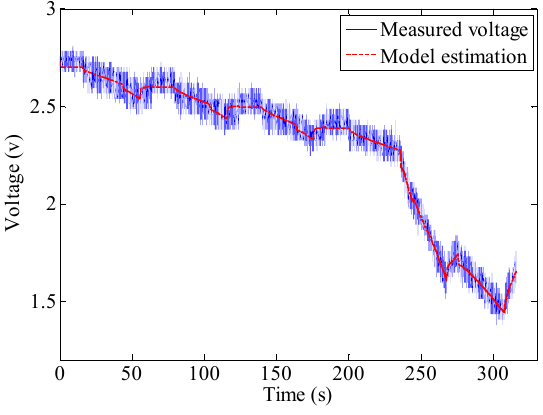
Figure 6. The measured and estimated voltages in the DST test.